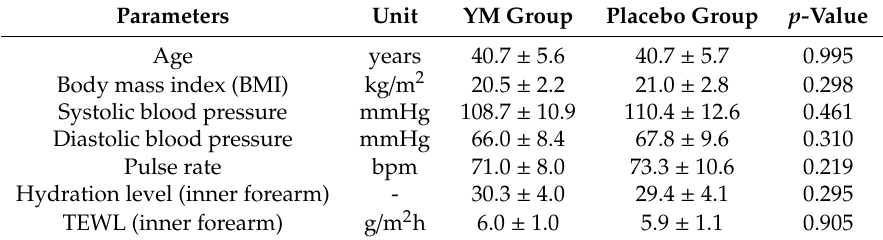
Table 2. Background characteristics of subjects at the pretrial